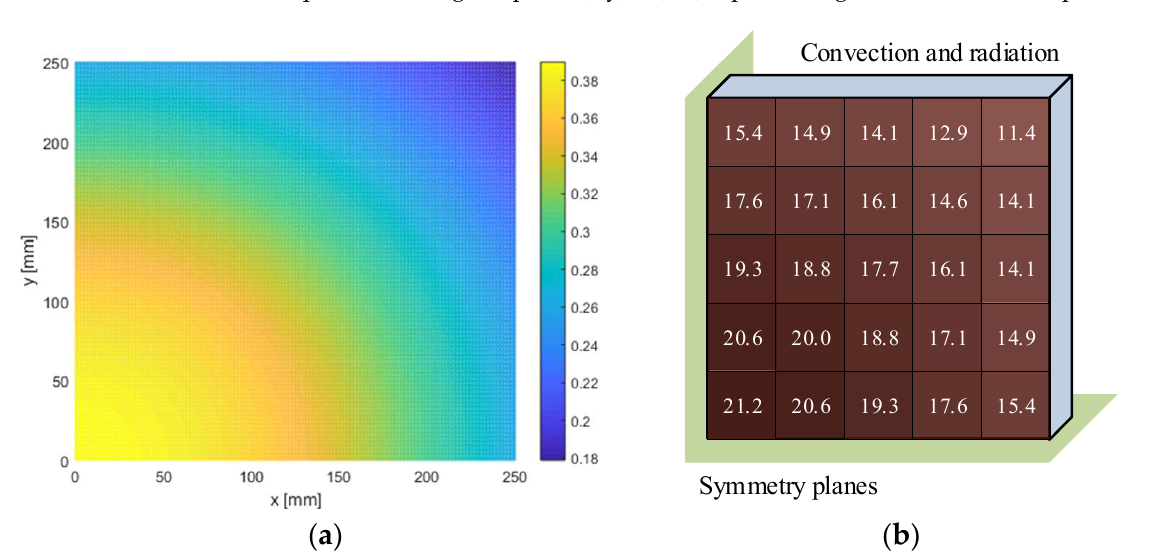
Figure 16. ( a ) View factors for the determination of the HF to be applied in the 3D-model; ( b ) applied incident radiant heat flux kW/m 2 (distance from the radiant panel d p = 350 mm) for the tests using a 64.7 kW/m 2 emissive power of the radiant panel.